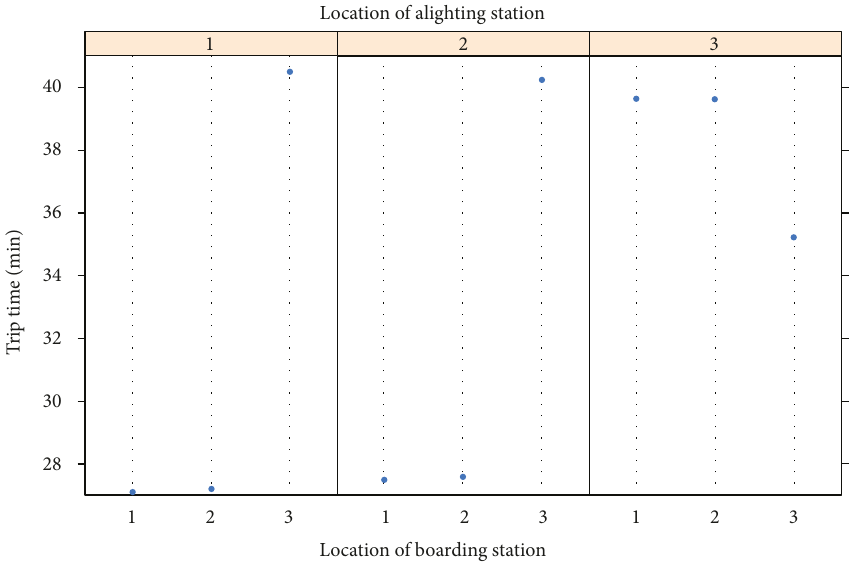
Figure 6: Interaction effects of boarding and the alighting stations’ locations on metro trip